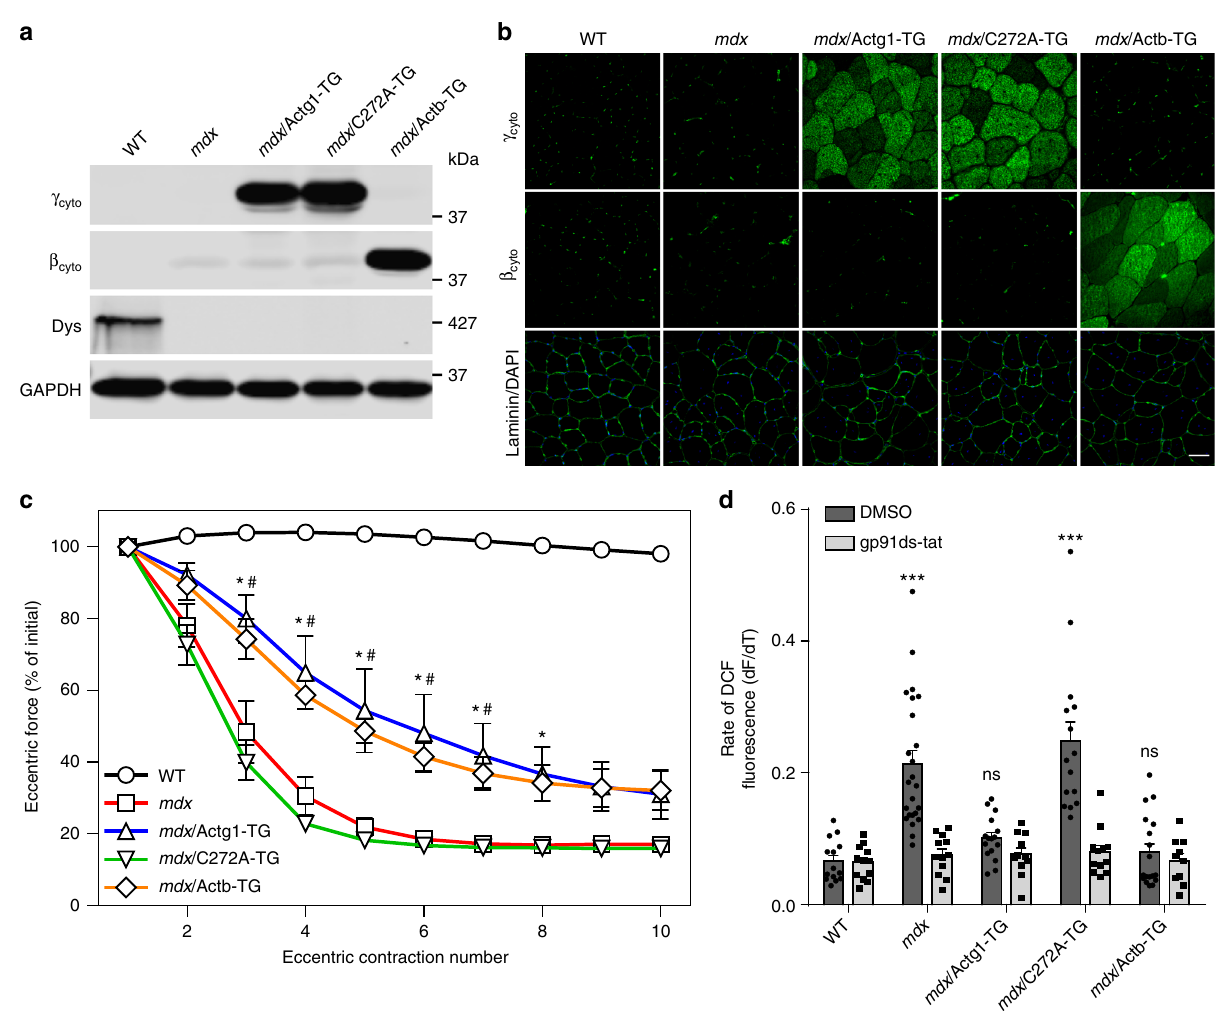
Fig. 6 Cysteine 272 of γ cyto -actin is necessary for protection of mdx muscle from eccentric contraction-induced force loss. a Immunoblot comparison of γ γ mdx gastrocnemius muscle. b Immuno fl uorescence analysis demonstrates C272A (C272A-TG), and β cyto (Actg1-TG), cyto cyto (Actb-TG) overexpression in similar distributions of γ cyto , γ cyto C272A , and β cyto in 10 µ m quadriceps cryosections. Scale bar = 50 µ m. c EDL muscles isolated from WT, mdx , mdx /Actg1- TG, mdx /C272A-TG, and mdx /Actb-TG mice were subjected to 10 eccentric contractions and the forces measured expressed as a percentage of the force generated during the fi rst eccentric contraction; n = 8 for WT and mdx /C272A-TG; n = 5 for mdx ; n = 6 for mdx /Actg1-TG and mdx /Actb-TG. *The mdx / Actg1-TG signi fi cantly different from mdx ( P ≤ 0.05), # mdx /Actb-TG signi fi cantly different from mdx ( P ≤ 0.05); two-way ANOVA. d Rate of DCF fl uorescence in single fl exor digitorum brevis (FDB) muscles from WT, mdx , mdx /Actg1-TG, mdx /C272A-TG, and mdx /Actb-TG mice exposed to cyclic stretch in the presence of DMSO (vehicle) or the NOX2 inhibitor gp91ds-tat; n = 9 for WT, mdx /Actg1-TG, and mdx /Actb-TG; n = 12 for mdx ; n = 7 for adjusted to their anatomical optimal length ( L o ) based on resting tension, with length being measured from the distal myotendonous junction to the proximal myotendonous junction using digital calipers. Prior to performing eccentric con- tractions, maximal isometric tetanic force ( P o ) was measured every 2 min by sti- mulating the muscle to contract for 200 ms at 175Hz until force plateaued, with this value being designated “ pre P o ” , or simply “ Pre ” . In our standard ECC pro- tocol, a series of 10 eccentric contractions were performed and the peak force of each contraction was recorded. For each ECC force measurement, the muscle was passively shortened to 95% L o and then stimulated for 200 ms while the muscle was simultaneously lengthened to 105% L o at a velocity of 0.5 L o /s. Each eccentric contraction was separated by 3min of rest before performing the next eccentric contraction to prevent fatigue 74 . The force measured at each eccentric contraction directly into Krebs Buffer at 20 mM immediately prior to bath assembly 47 . The was expressed as a percentage of the force produced during the fi rst ( “ initial ” ) control mdx group used standard Krebs Buffer without NAC. For both groups, contraction. The value of “ n ” for all ECC experiments is de fi ned as “ number of EDL muscles were incubated for 30 min so NAC could ef fi ciently penetrate the muscle before being subjected to the standard ECC protocol. For Fig. 4d, the standard ECC protocol was used for 10%: mdx and 10%: mdx / PrxII – / – experiments (solid lines). For the other two experiments (dash lines), the standard ECC protocol was used except that a 5% length change was performed For Fig. 1a, mdx muscles were subjected to either the standard ECC protocol instead of a 10% change. Here, EDL muscles were passively shortened to 97.5% L o described above or the same protocol substituting isometric contractions for and then stimulated for 200ms while the muscle was simultaneously lengthened to